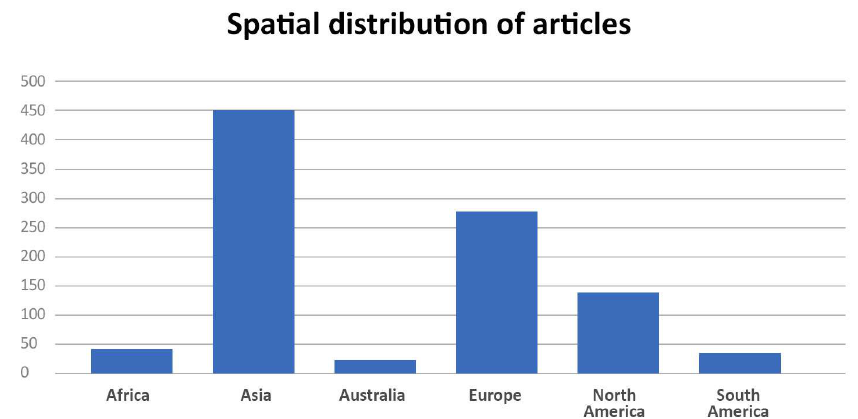
Figure 10. A graph of country production of articles used for this research.